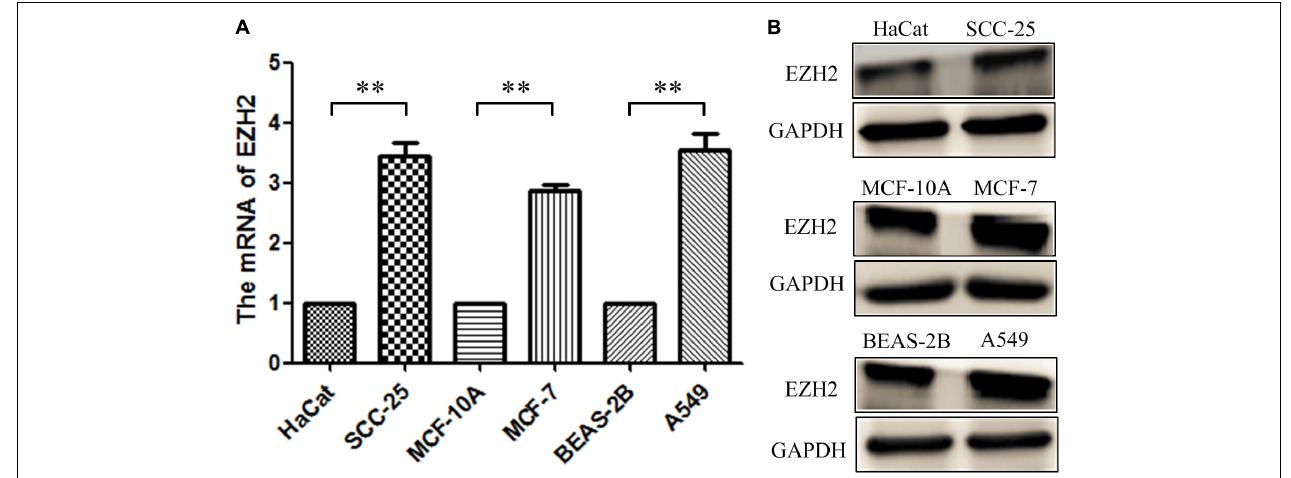
FIGURE 2 | The expression of EZH2 in three tumor cells. (A) RT-qPCR. (B) Western blotting. ** P < 0.01.